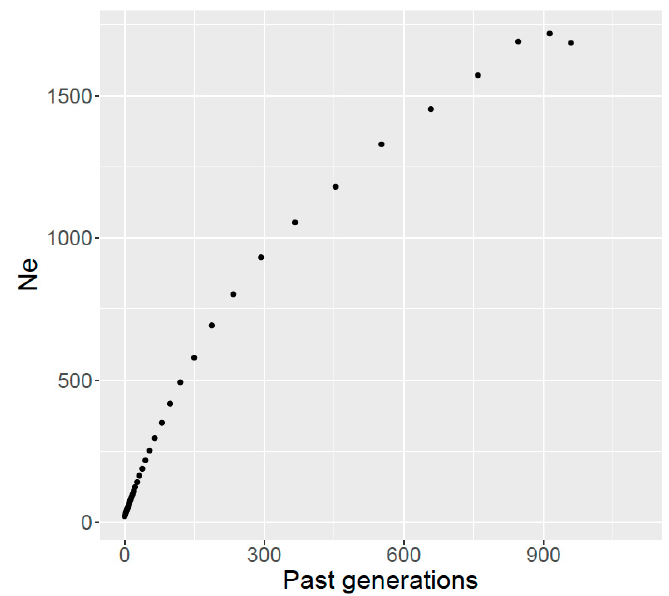
Figure 5. Estimation of ancestral e ff ective population size (Ne) in past generations, estimated from linkage disequilibrium.